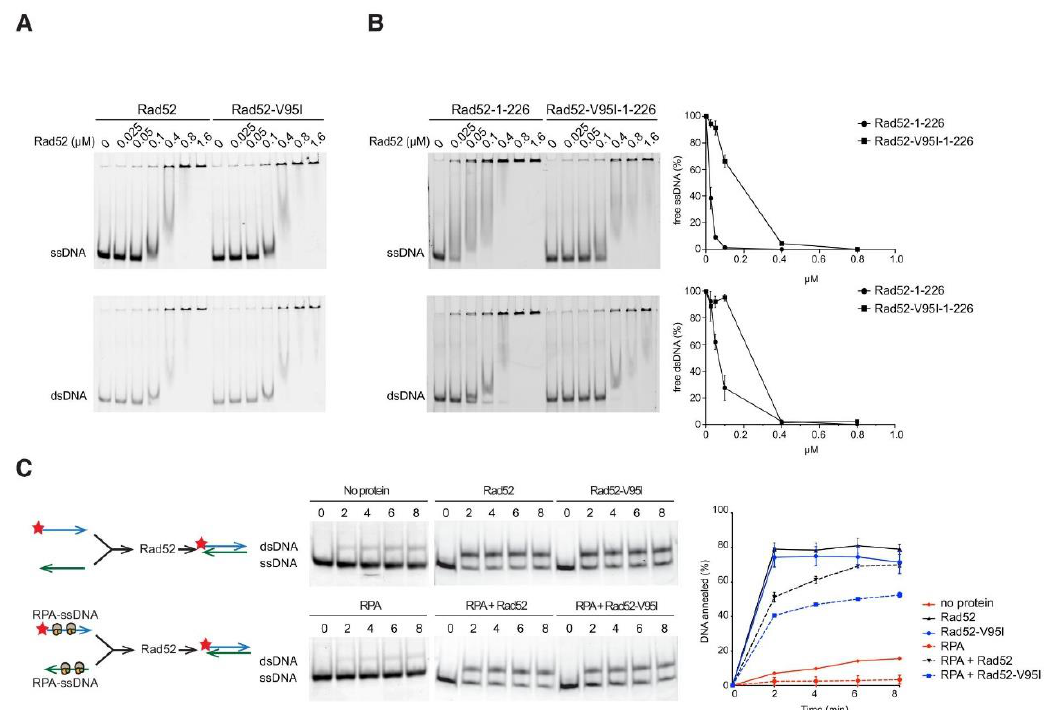
Figure 6. DNA binding and strand annealing activity of Rad52-V95I. ( A ) Binding of purified Rad52-FLAG and Rad52-V95I-FLAG to ssDNA (0.27 µM nt) or dsDNA (0.27 µM nt). ( B ) Same experiment with a peptide covering the N-terminal domain of Rad52 or Rad52-V95I. The quantification of free ssDNA and dsDNA relative to the peptide concentration is shown. ( C ) Rad52-FLAG or Rad52-V95I-FLAG annealing activity of a Cy5-labeled 48 nucleotide-long ssDNA to its complementary primer previously coated or not with RPA. The ratio between annealed DNA and the sum of ssDNA and dsDNA was plotted. Data are presented as the mean ± SEM of at least three independent experiments.